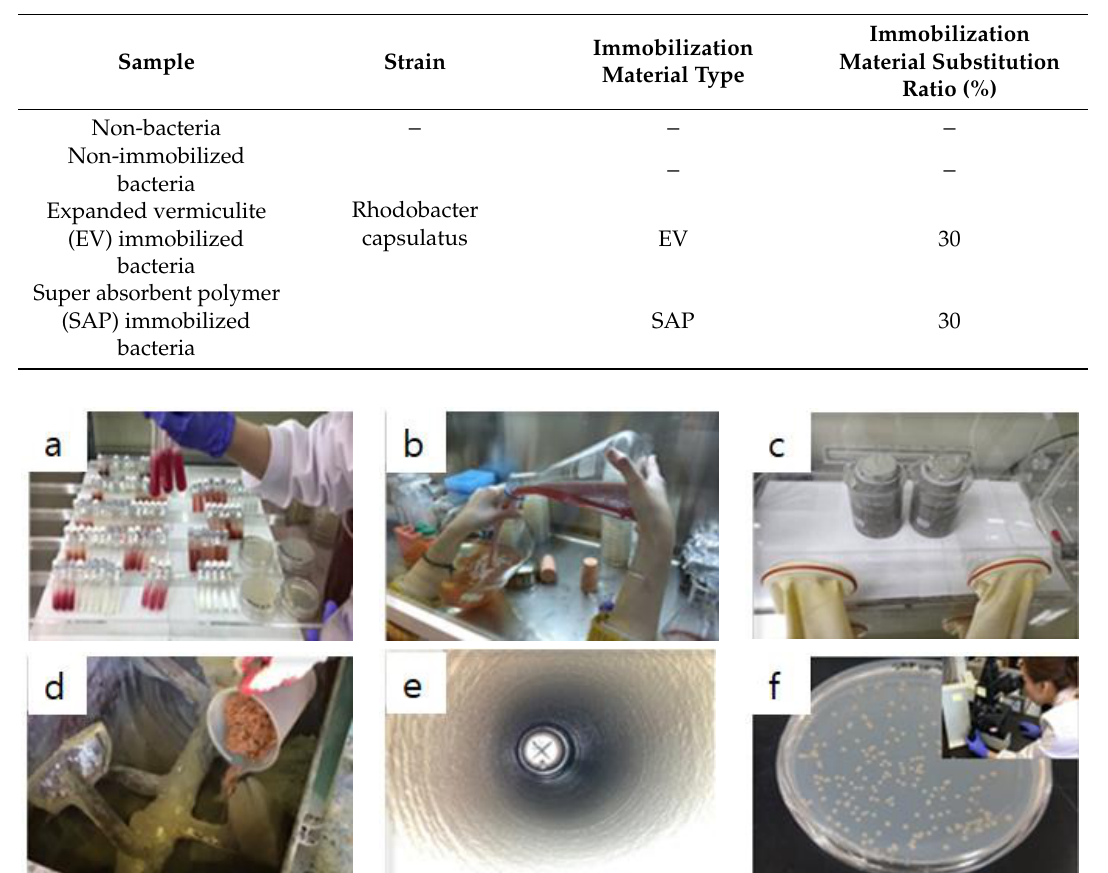
Table 2. Mix proportions for bio-slime coating material.